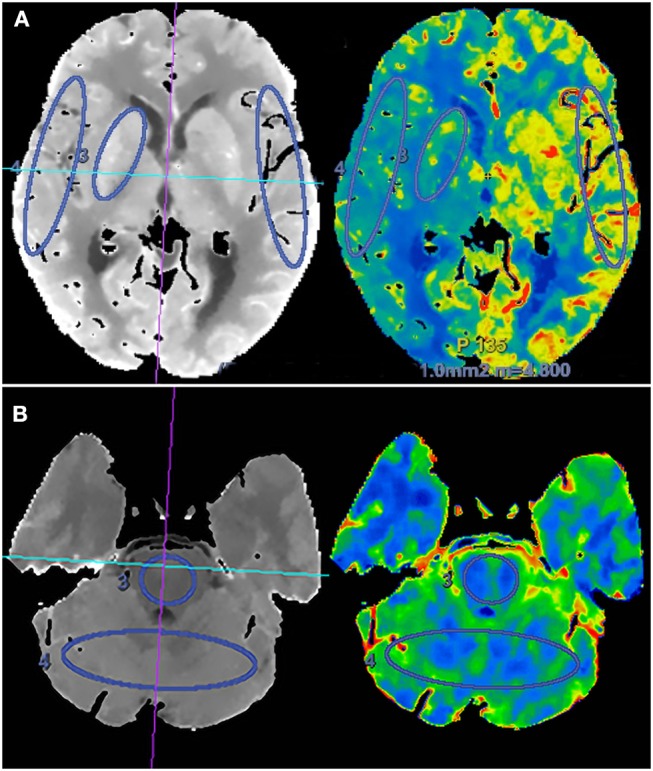
Schematic diagram of regions of interest (ROIs) in the region of perforating artery territory (PAT) and cortical artery territory (CAT) in anterior circulation (A) and posterior circulation (B).